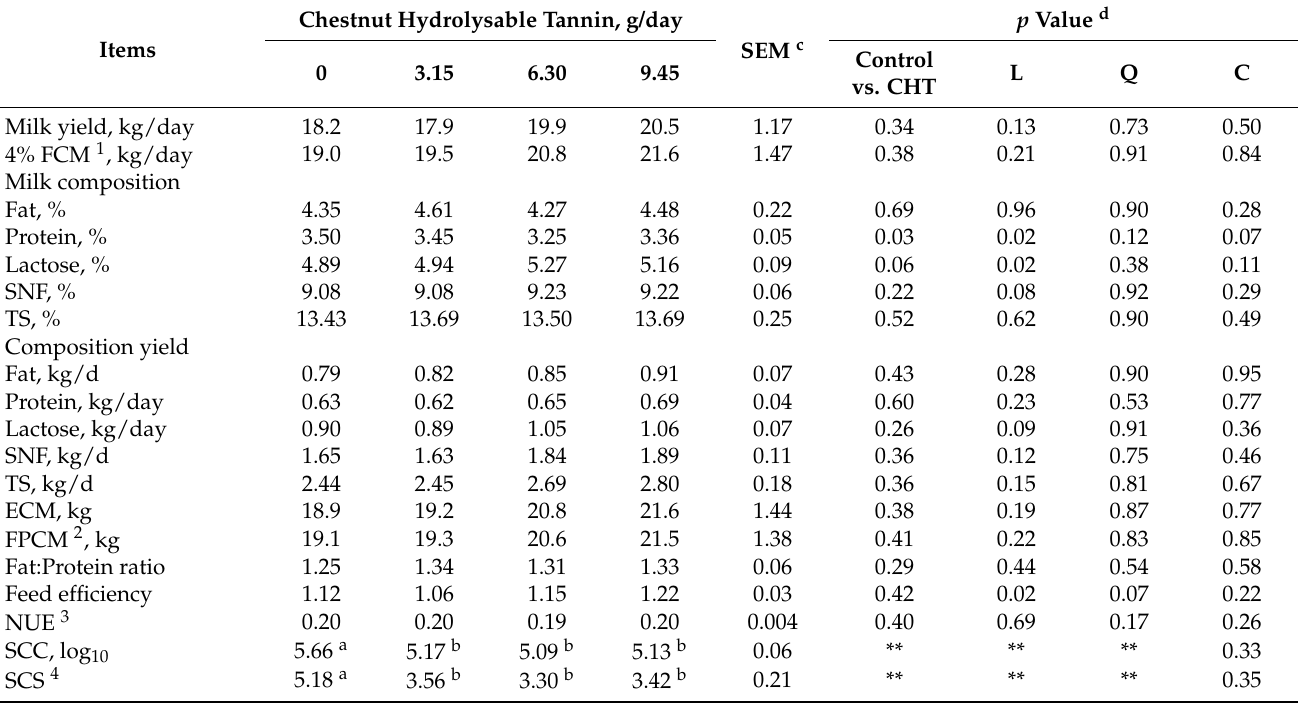
Table 4. Milk yield and milk composition in lactating dairy cows supplemented with various levels of chestnut hydrolysable tannin.